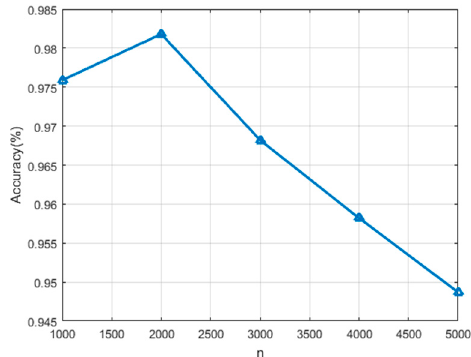
Figure 5. Effect of the number of superpixels n on the classification accuracy. Figure 5. E ff ect of the number of superpixels n on the classification accuracy.